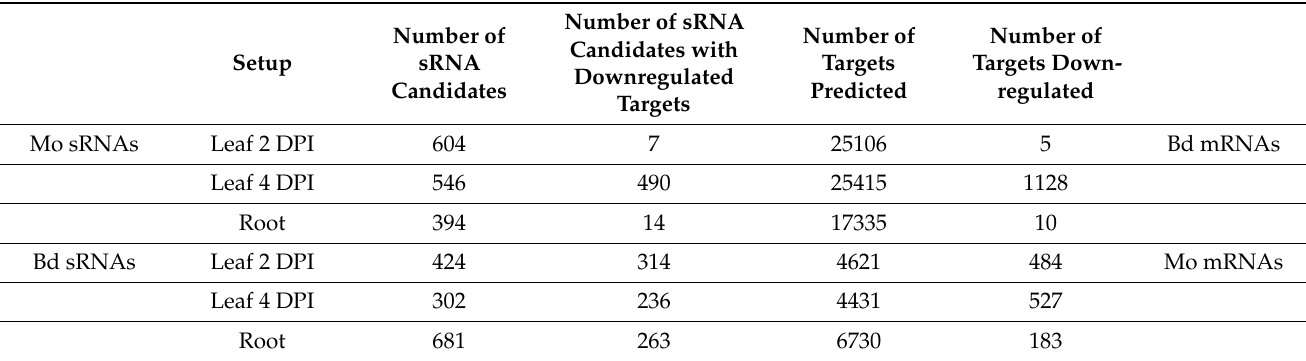
Figure 10. Venn diagram of downregulated predicted RNAi targets in M. oryzae and B. distachyon . Significantly downregulated (FC < 0 padj < 0.05) ( A ) Bd mRNA targets with complementarity to putative Mo sRNAs effectors shared between setups. ( B ) Mo mRNA targets with complementarity to putative Bd sRNA effectors. Setups: Leaf biotrophic phase (2 DPI) Leaf necrotrophic phase (4 DPI), and root. Transcript downregulation was assessed from mRNAseq data with DESeq2. Table 5. Overview of the number of predicted cross-kingdom sRNA candidates (20–22 nt) and their corresponding target mRNAs after target downregulation confirmation (FC < 0, padj <